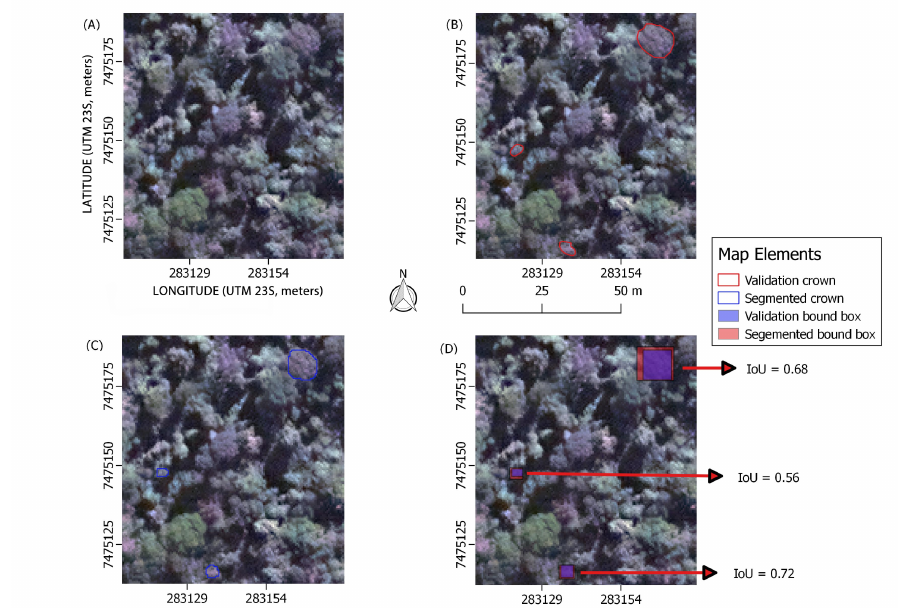
Figure 16. The IoU result of some examples. ( A ) A region of Santa Genebra Reserve; ( B ) Evaluation set examples; ( C ) The Mask R-CNN result of tree crown delineation; ( D ) The IoU result; in other words, the overlap between the response bounding box and the evaluation bounding